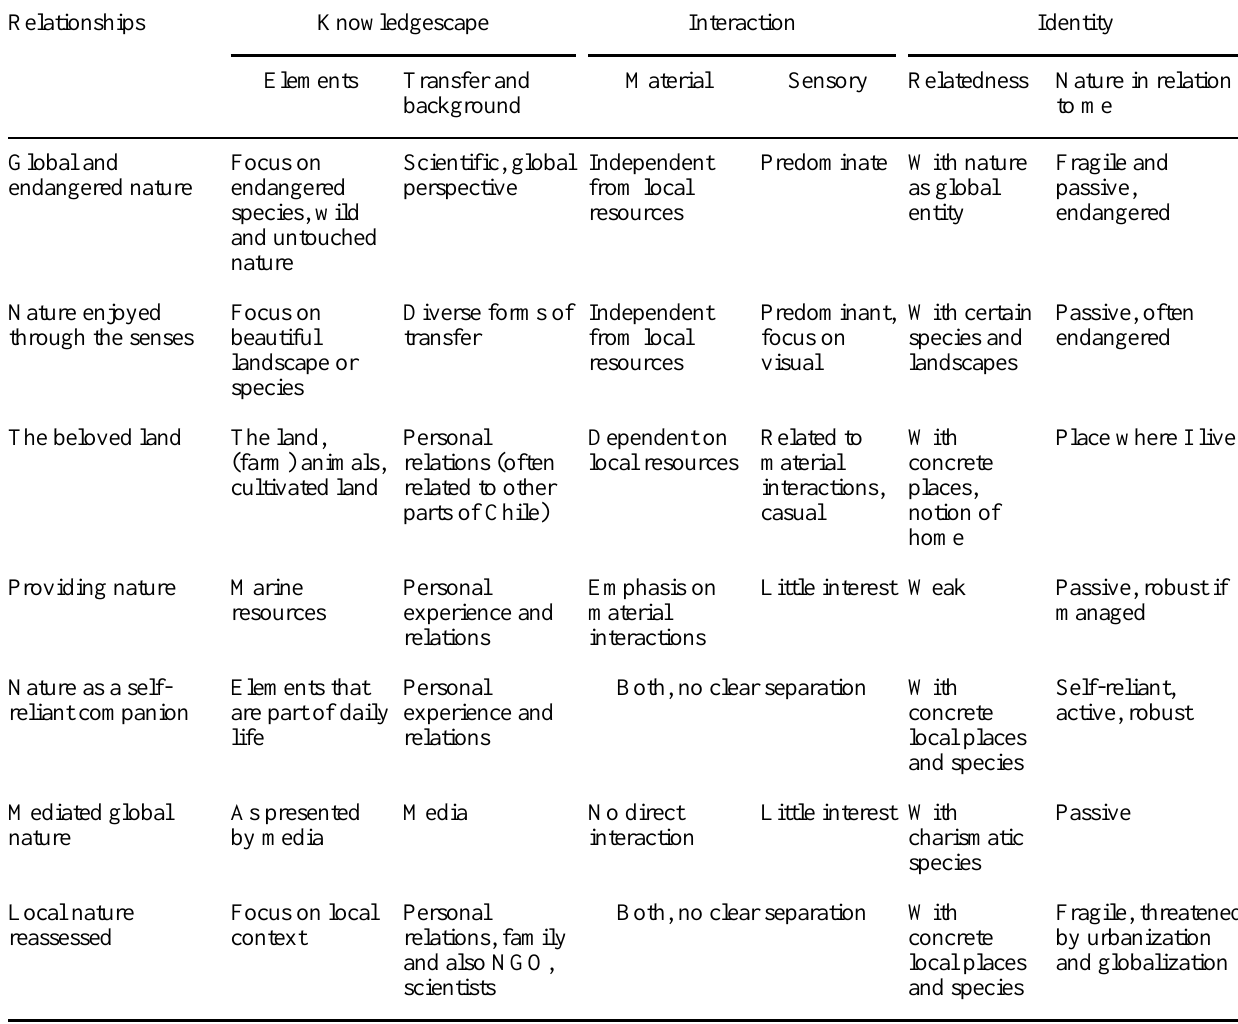
Table 2 . Categories, subcategories, and dimensions characterizing people's relationships with nature in the Cape Horn Biosphere